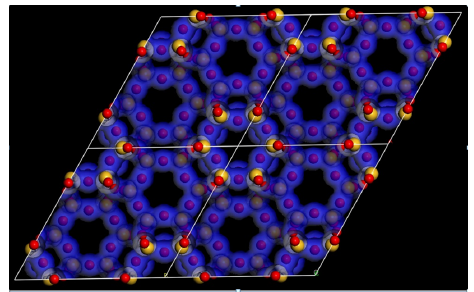
Figure 2. View of the AFX structure along the c- axis; yellow spheres - T-atoms, red spheres - oxygen atoms, blue patterns - visualization of electron density distribution.